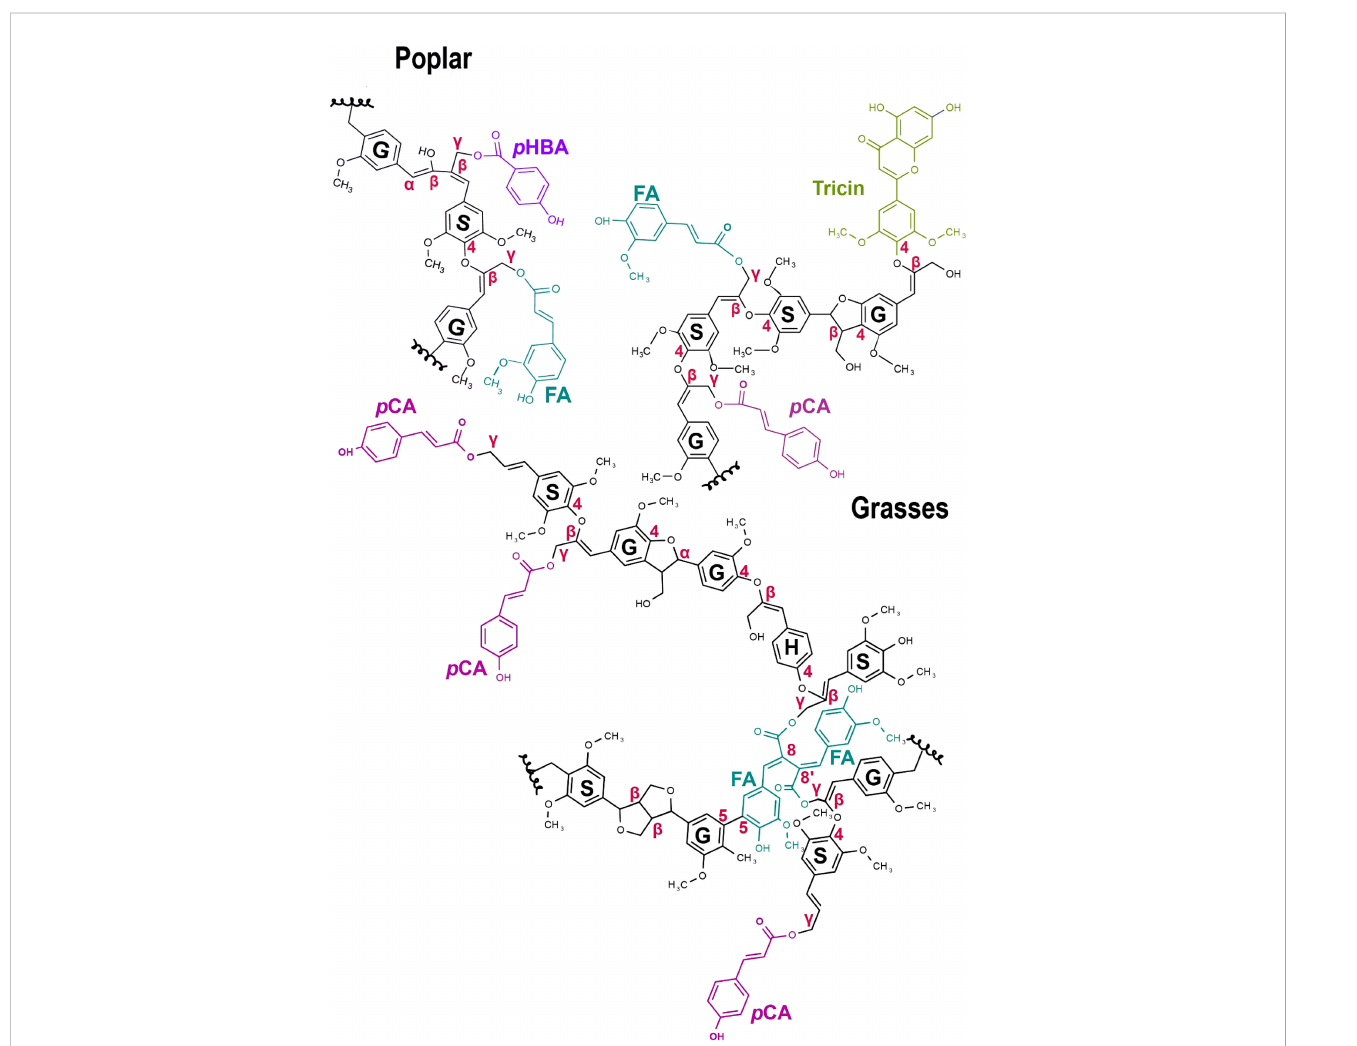
FIGURE 3 Hydroxycinnamoylated grass and poplar lignin polymer models. p- Coumaric acid ( p CA - pink) and Ferulic acid (FA – turquoise) occur on lignin in commelinid grasses. Tricin (green) is a grass-speci fi c fl avonoid biosynthetic product that occurs as pendant groups on lignin. p -hydroxybenzoate ( p HBA - purple) and FA (at low levels) occur in poplar and other dicots. g -Feruloylated lignin naturally occurs in some non-commelinid grasses and dicots, generally at lower levels (Karlen et al., 2016). Here, we have only shown a FA dimer. Canonical lignin monomers include S, Syringyl lignin; G, Guaiacyl lignin; and H – p -hydroxyphenyl lignin. SGH monomers in the fi gure do not represent their actual ratios. The different C-C, ether ( b -O-4), and g -ester bonds occurring in the lignin polymer are highlighted in